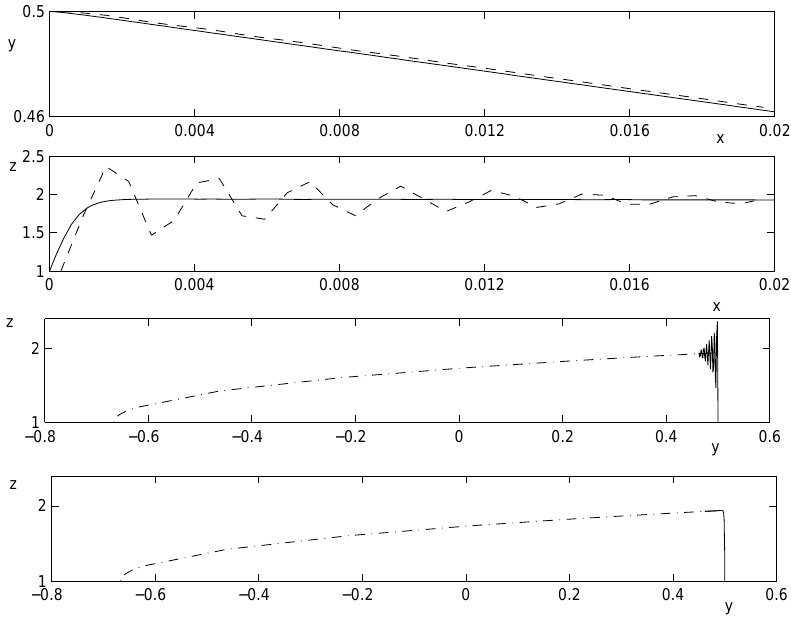
Figure 4. Solution of the van der Pol equation (6.1); (a)–(b) functions y ( x ) ,z ( x ) , dashed lines denote the PCA solutions; (c) phase curve according to the PCA solutions; (d) phase curve for the wavelet